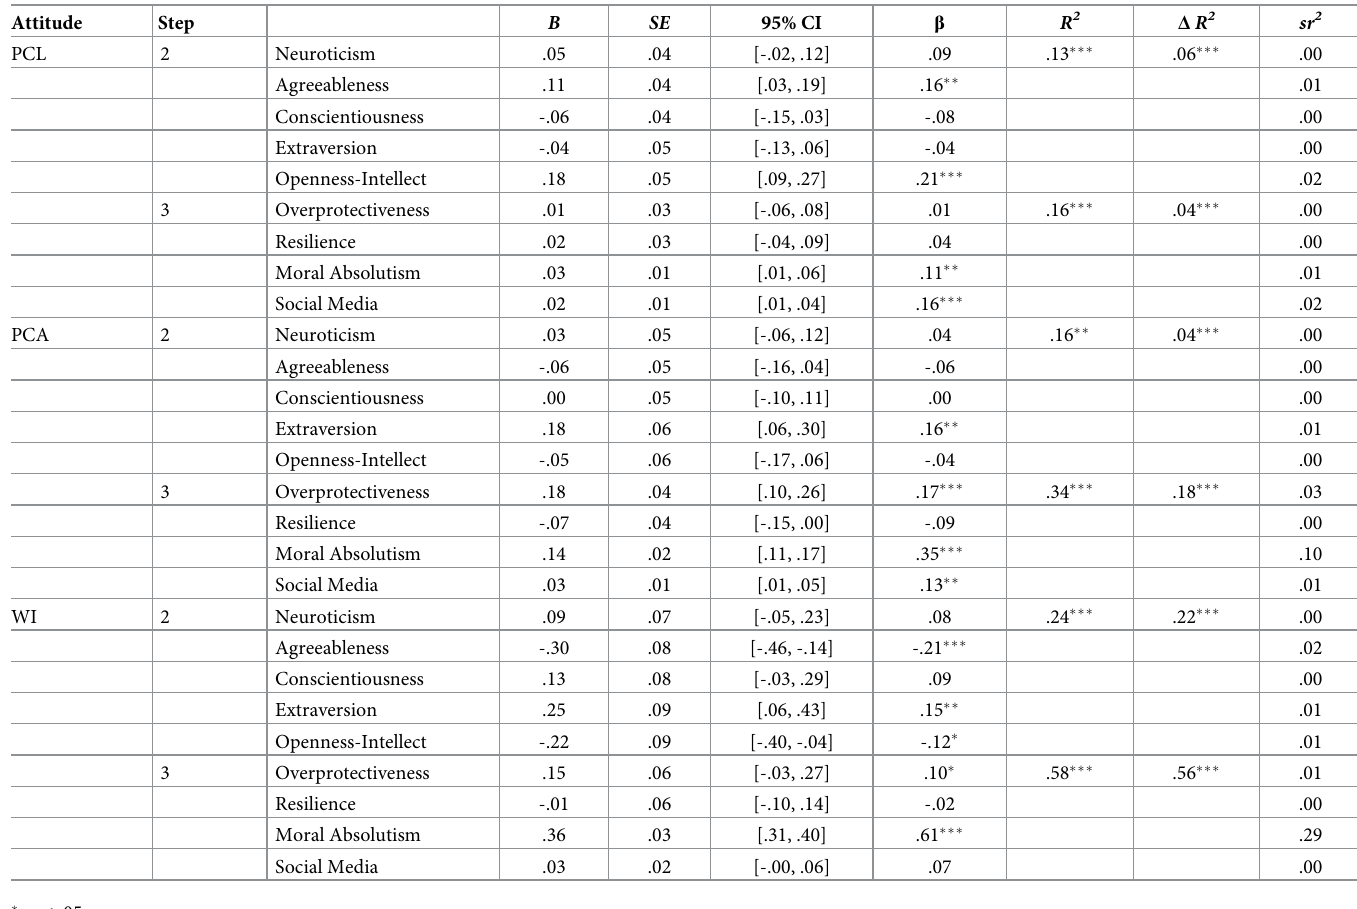
Table 7. Step 3 of hierarchical multiple regression of big-5 traits, parenting, and personal